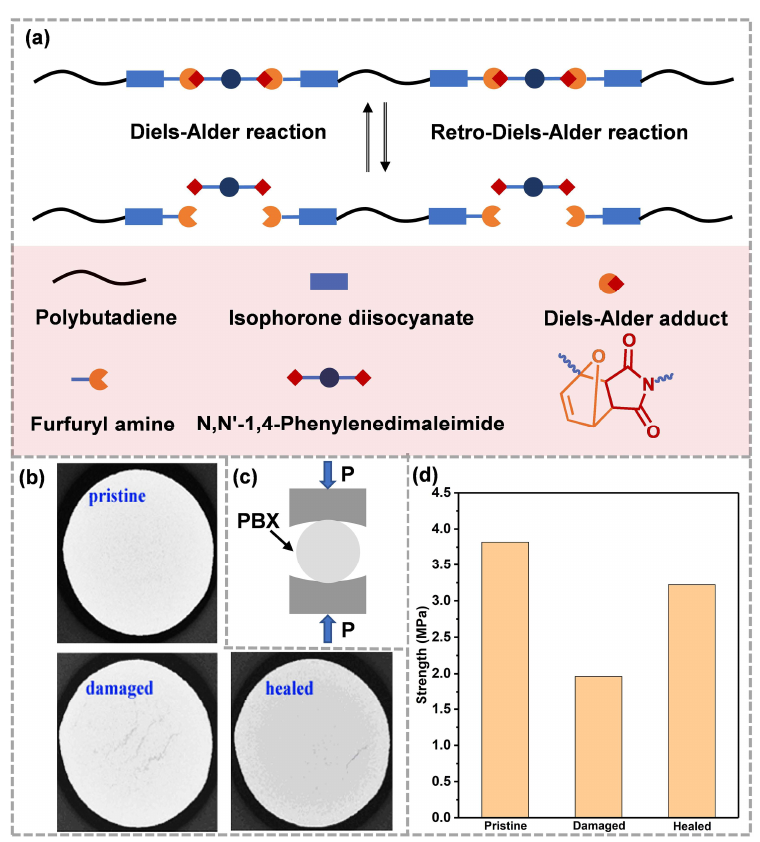
Figure 3. ( a ) Thermoreversible process of FTPB-DA for self-healing (reproduced from Ref. [58] with permission; Copyright Royal Society of Chemistry, 2021), ( b ) CT images, ( c ) Brazilian test method and ( d ) mechanical strength of DAPU-HMX (reproduced from Ref. [59] with permission; Copyright Elsevier,